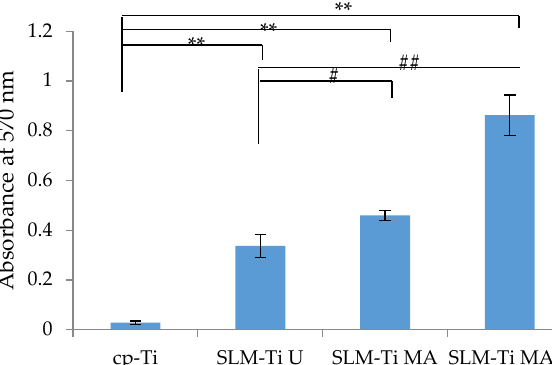
Figure 9. Mineralized matrix in MC3T3-E1 cells cultured for 21 days on the cp-Ti and SLM-Ti as measured by Alizarin red-S. (n = 3), ** different from the cp-Ti at p < 0.01, # different from SLM-Ti U at # p < 0.05, ## p < 0.01.